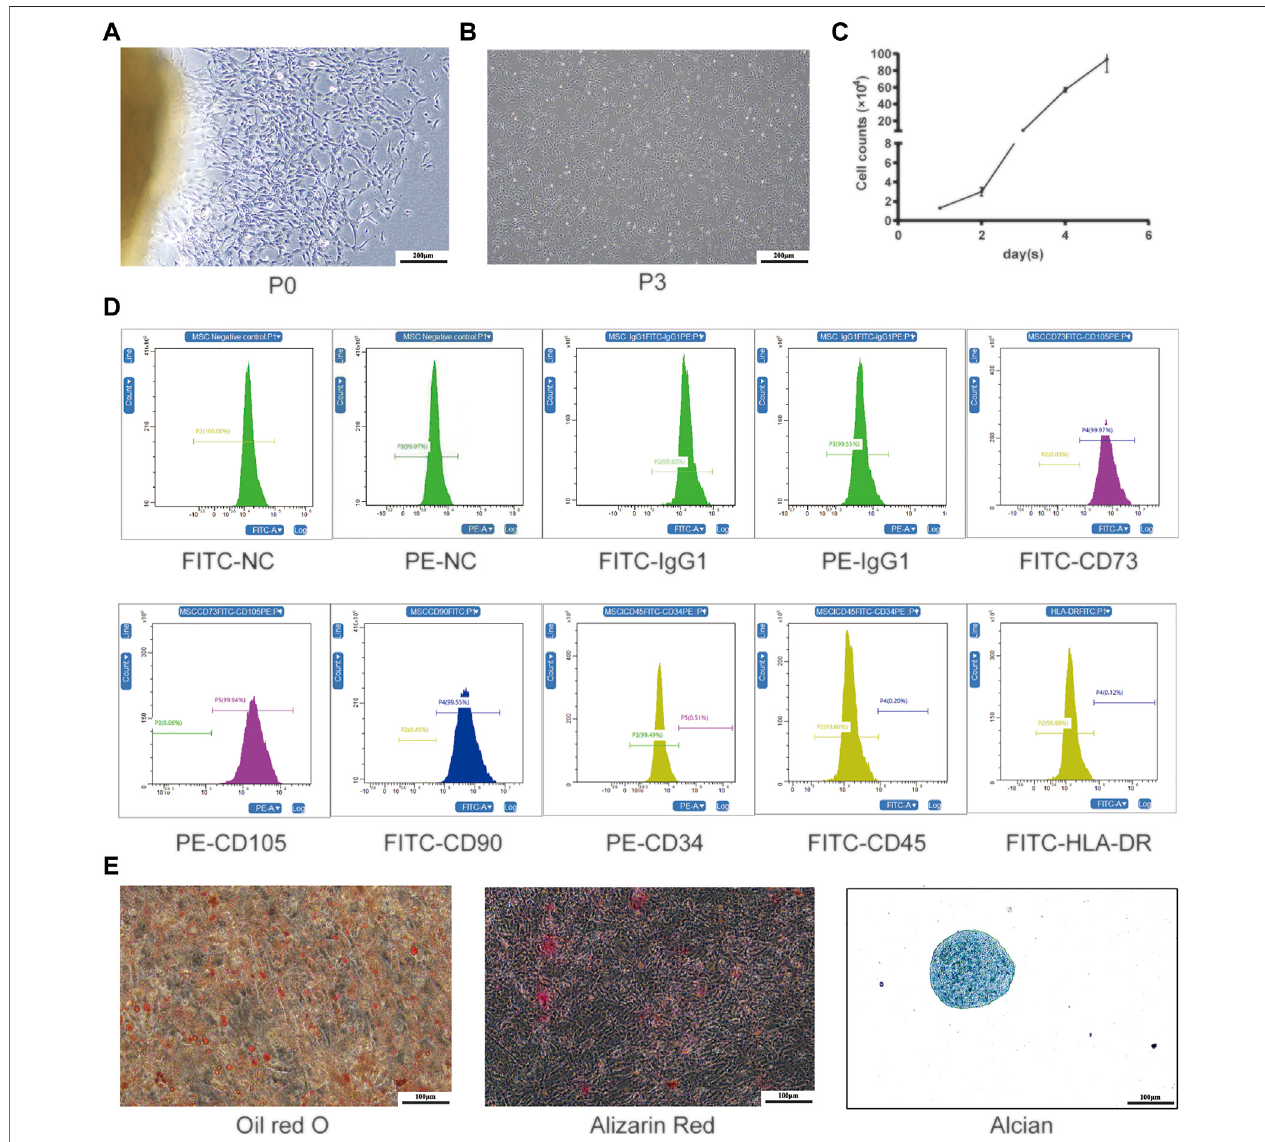
FIGURE 2 | Isolation and production of UC-MSCs. (A) Primary cultured UC-MSCs; (B) morphological feature and (C) growth curve of UC-MSCs at the third passage; (D) surface antigen labels of UC-MSCs; (E) induced differentiation of UC-MSCs was stained by oil red O, Alizarin Red, and Alcian Blue.